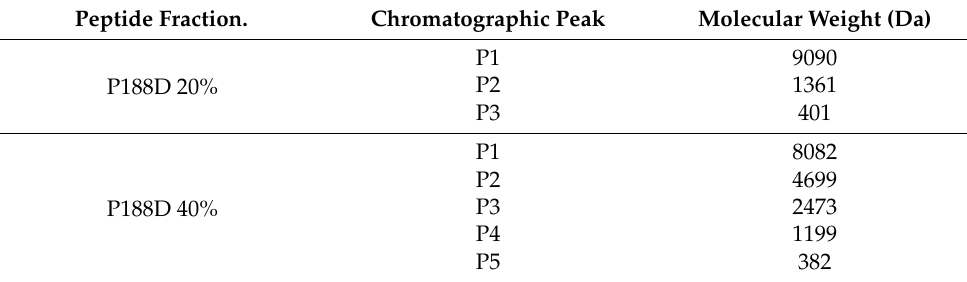
Figure 2. Keratinocyte proliferation ( A ) and migration rate ( B ) (in comparison to the control) in the presence of peptide fractions (45 g/mL). Table 1. Peptide fractions and respective molecular weight. Peptide